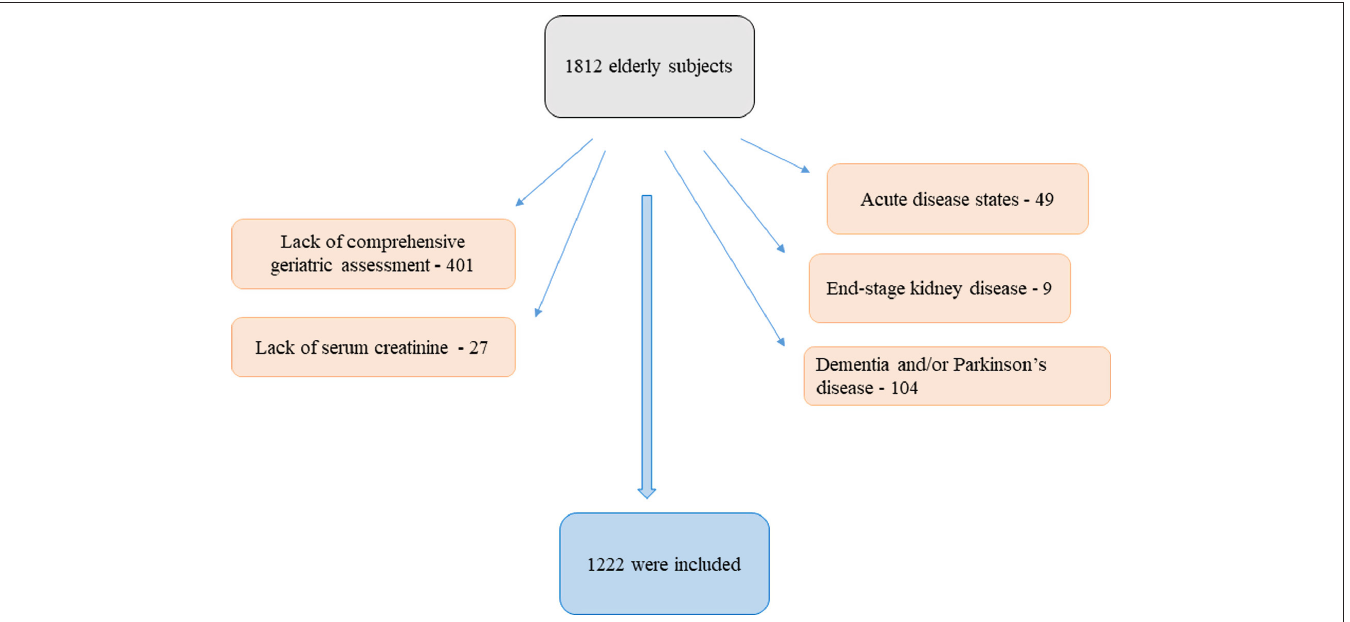
Figure 1. Flowchart of the